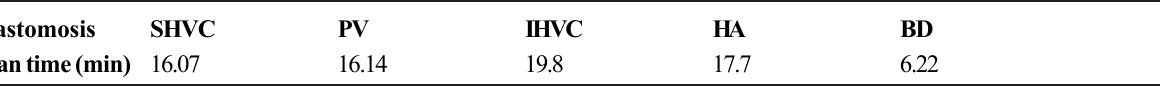
TABLE 2 - Mean time to perform the anastomosis Anastomosis SHVC PV Mean time (min) 16.07